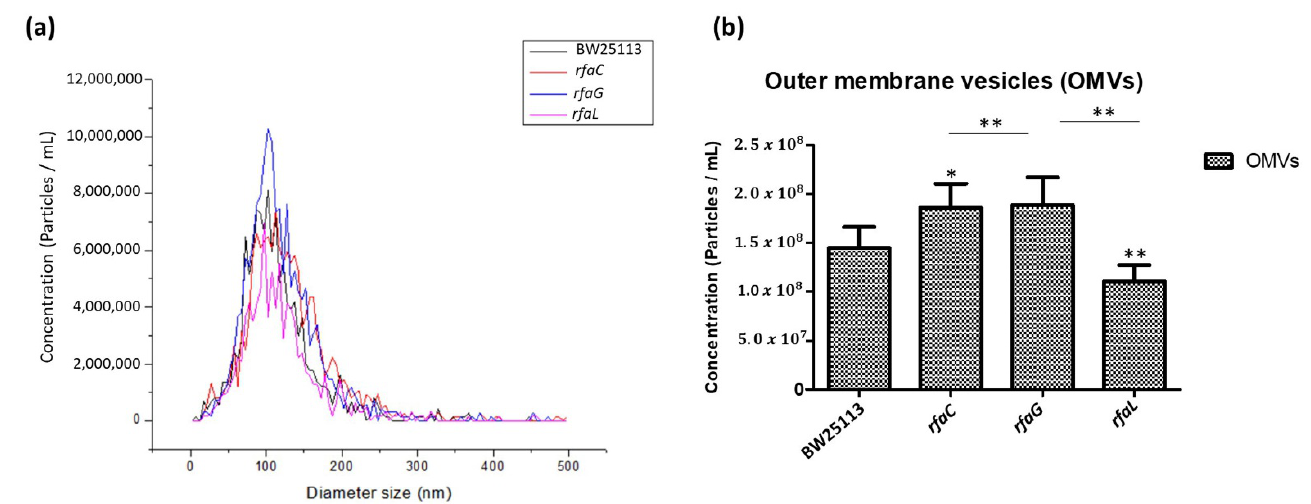
Figure 3. Small and large outer membrane vesicle (OMV) populations purified from a heterogeneous population of OMVs. ( a ) OMV population diameter sizes (nm) of E. coli BW25113, rfaC knockout (Δ rfaC ), rfaG knockout (Δ rfaG ), and rfaL knockout (Δ rfaL ) strains, respectively, were evaluated using Nanoparticle Tracking Analysis (NTA); ( b ) average diameter size of E. coli BW25113, rfaC knockout (Δ rfaC ), rfaG knockout (Δ rfaG ), and rfaL knockout (Δ rfaL ) OMVs presented in nm in each concentration (particle/mL). * p < 0.05 and ** p < 0.01 indicate statistical significance.